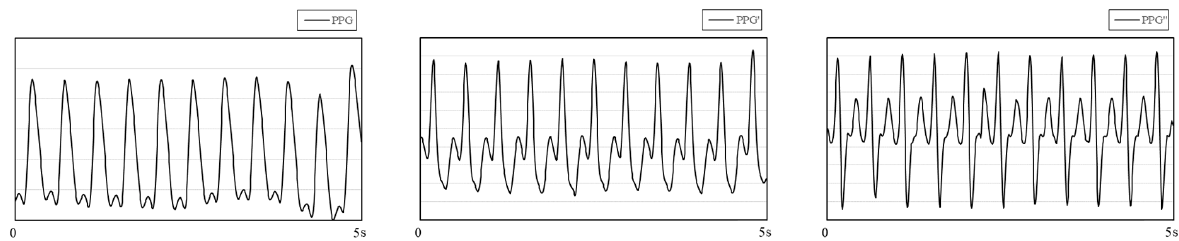
Figure 1. PPG (photoplethysmography) and its first derivative (PPG (cid:48) ) and second derivative (PPG”). The data comes from the MIMIC